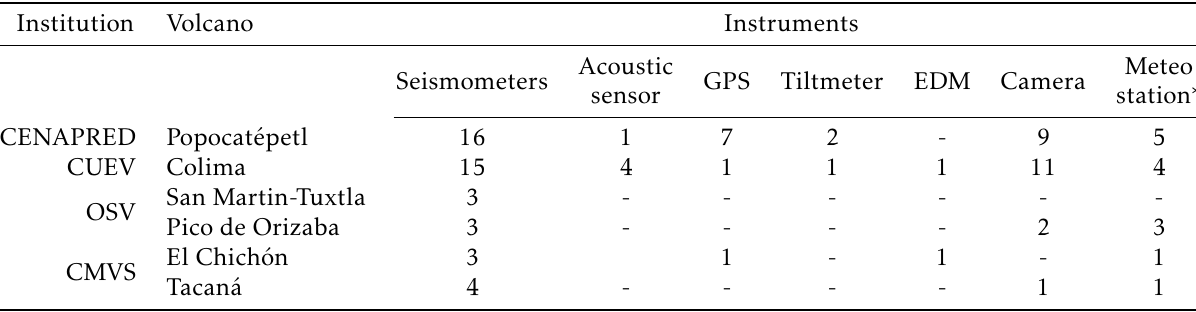
Table 1: Monitoring equipment deployed at each volcano.